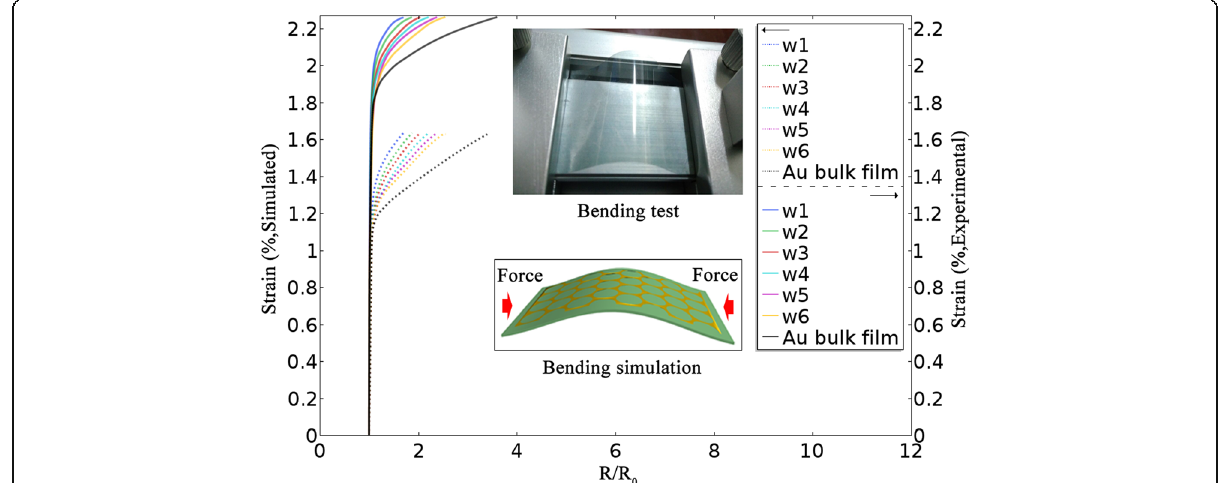
Fig. 5 The strain level vs. R / R 0 for AuNM electrodes and Au bulk film ( R / R 0 , where R 0 is the initial resistance under zero strain). The insets show maps of the AuNM electrodes during bending test and bending simulation, respectively